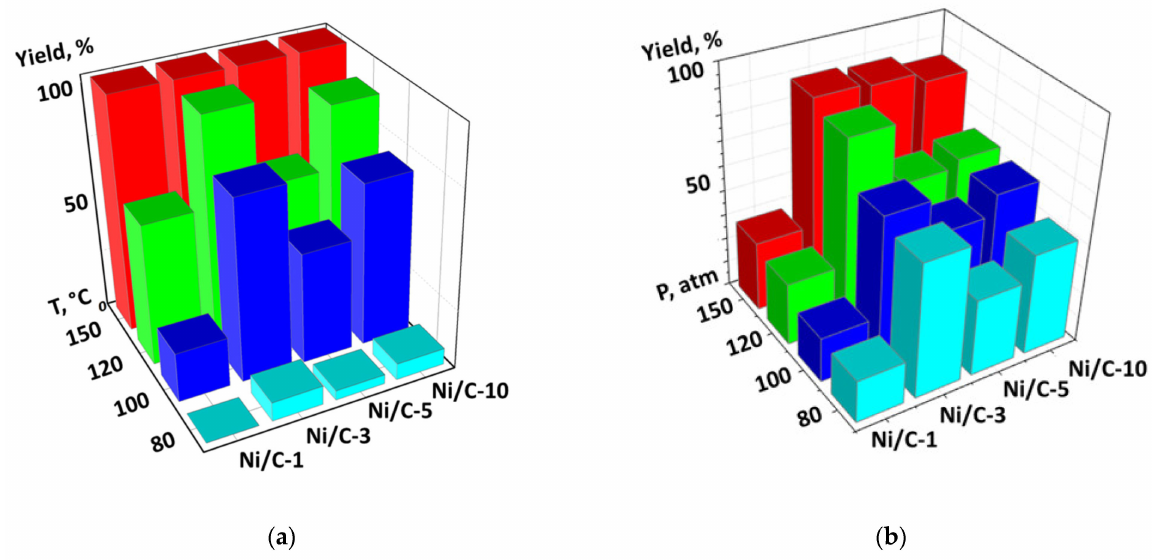
Figure 9. Diagram showing the dependency of the yield of 1,2,3,4-tetrahydroquinoline in the hydro- genation of quinoline vs. temperature. p(H 2 ) = 100 atm. ( a ) and a diagram showing the dependency of the yield of the same compound on p(H 2 ) at T = 100 ◦ C ( b ). In both cases, the catalyst loading was 0.5 mol % (counting per Ni), 24 h,